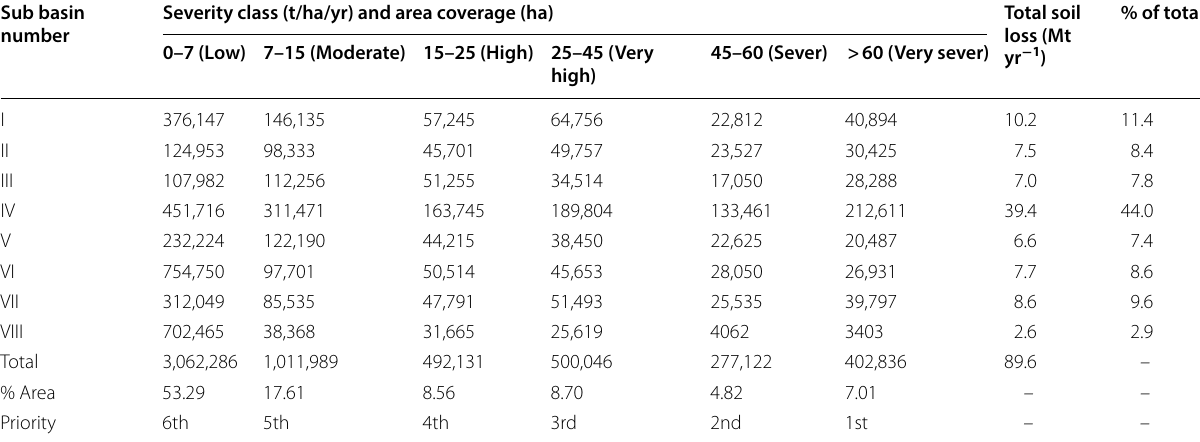
Table 5 Soil loss rates and severity classes of major sub